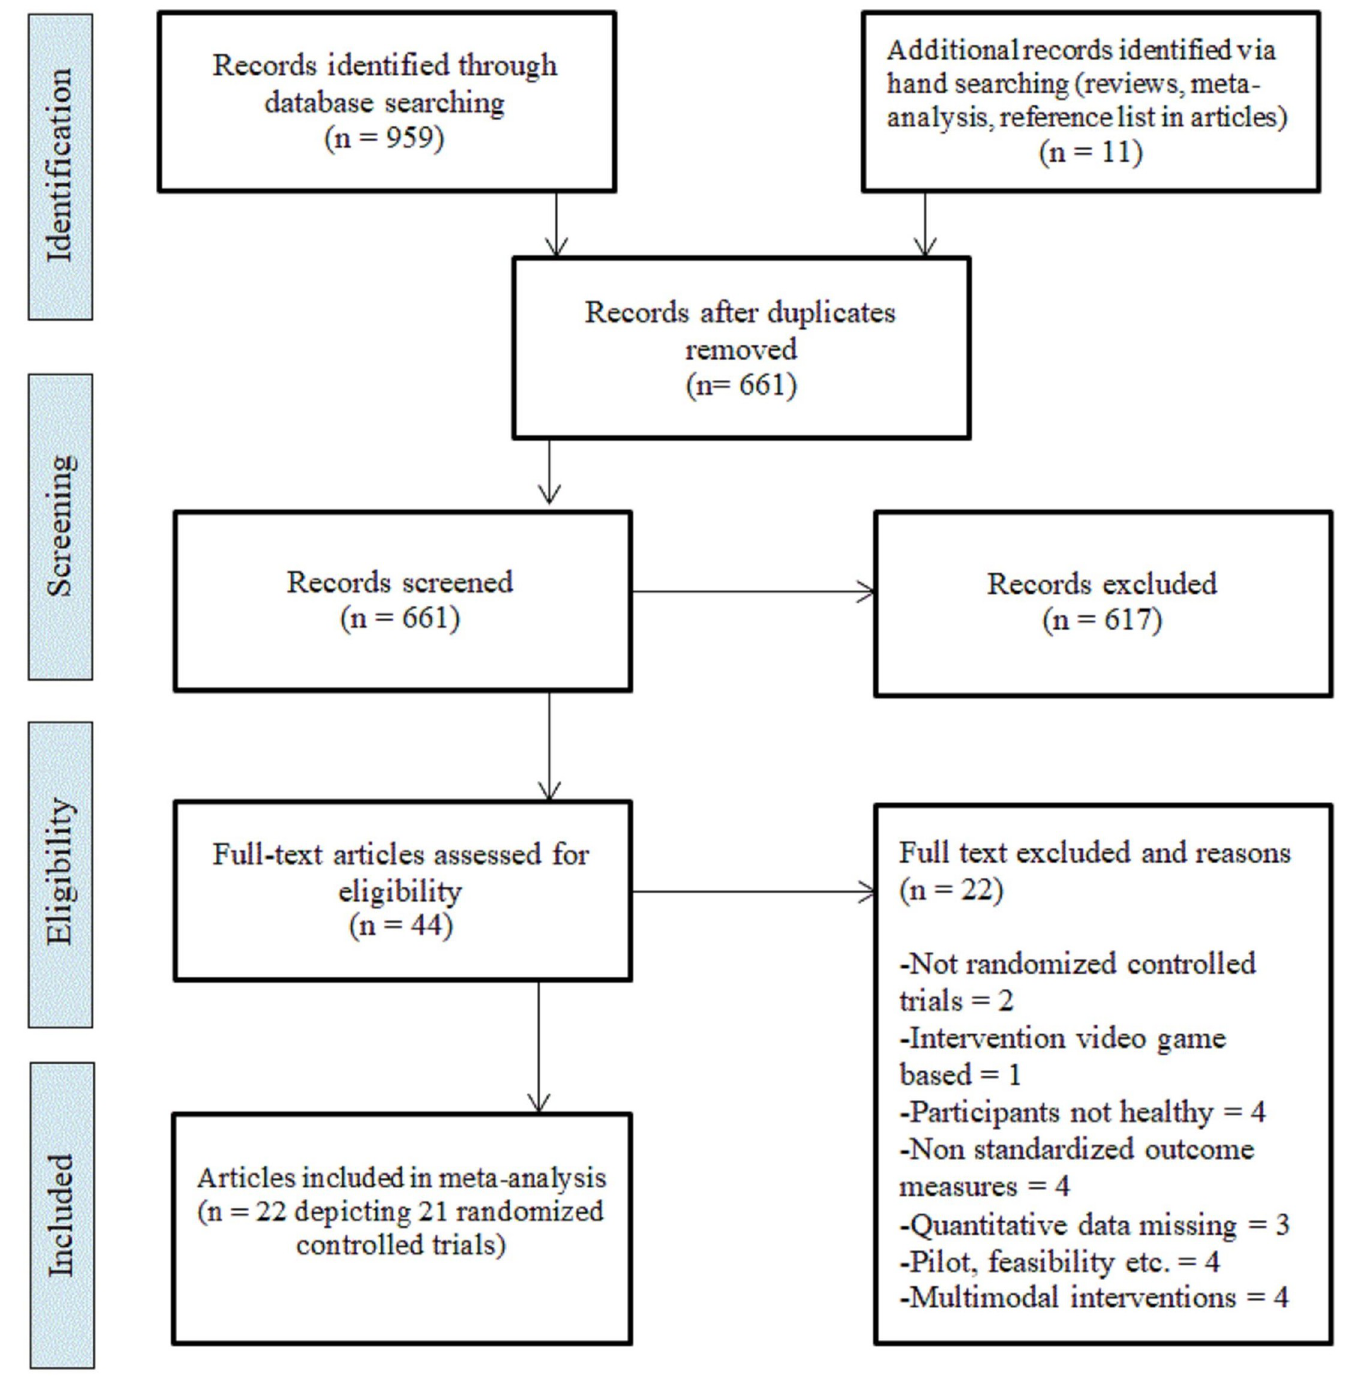
Fig 1. PRISMA flow